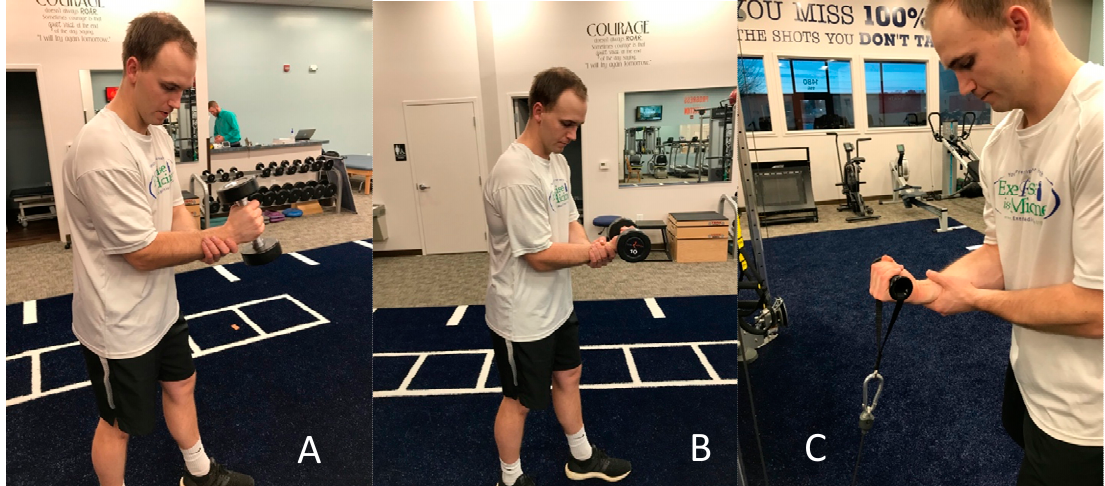
Figure 1. Eccentric elbow flexion with the wrist in ( A ) neutral with dumbbell, ( B ) supinated with dumbbell, and ( C ) supinated with pulley. Each image is shown using the contralateral arm as support during the eccentric lowering of the motion.